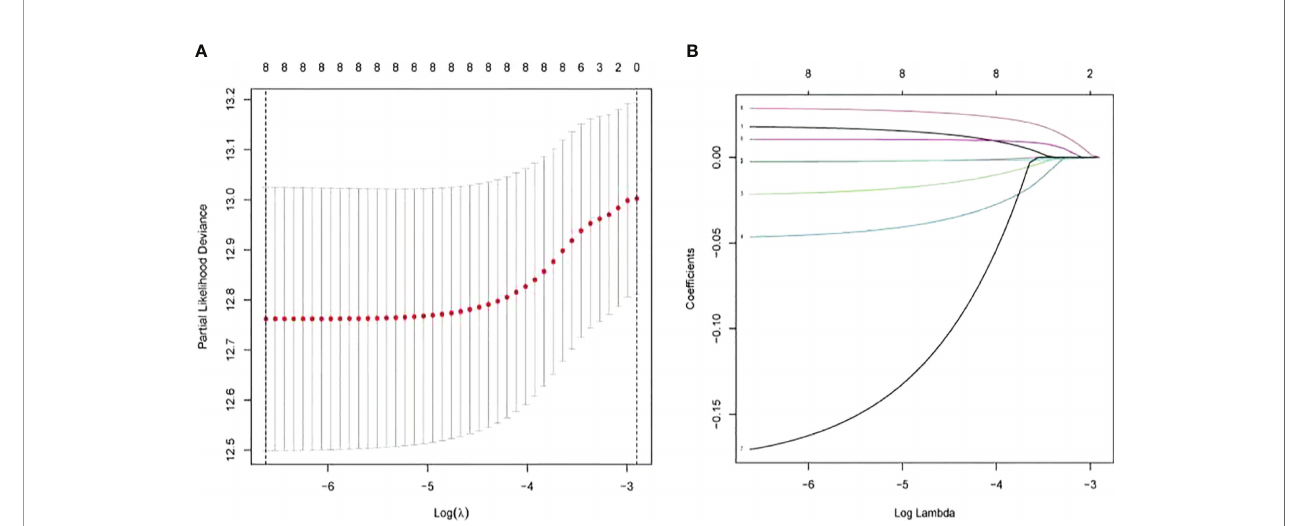
FIGURE 8 | Construction of risk model based on pyroptosis-related genes by the least absolute shrinkage and selection operator (LASSO)-penalized Cox